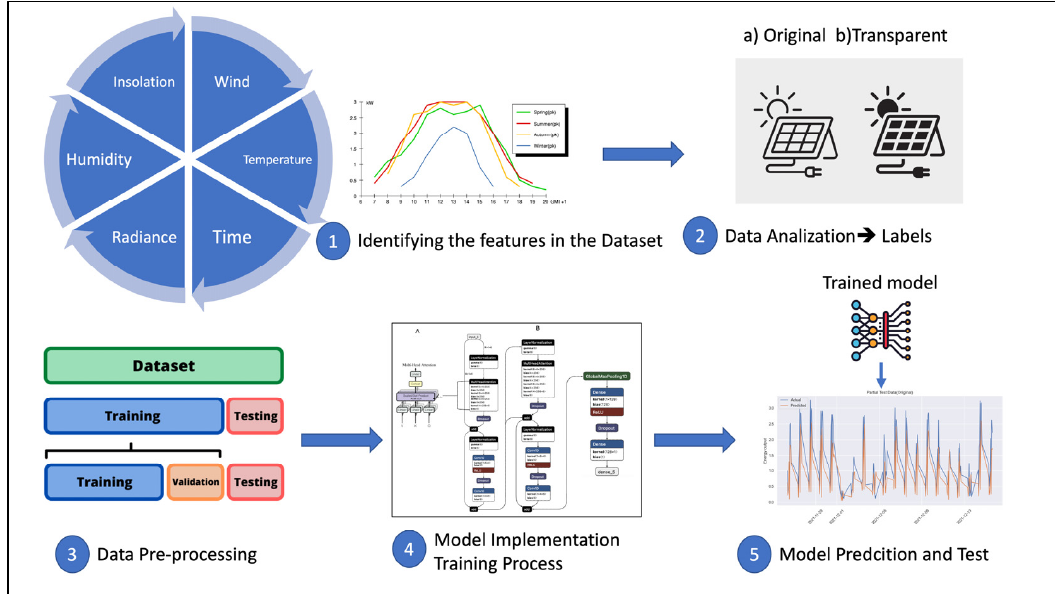
Figure 5. General workflow of the implemented system .